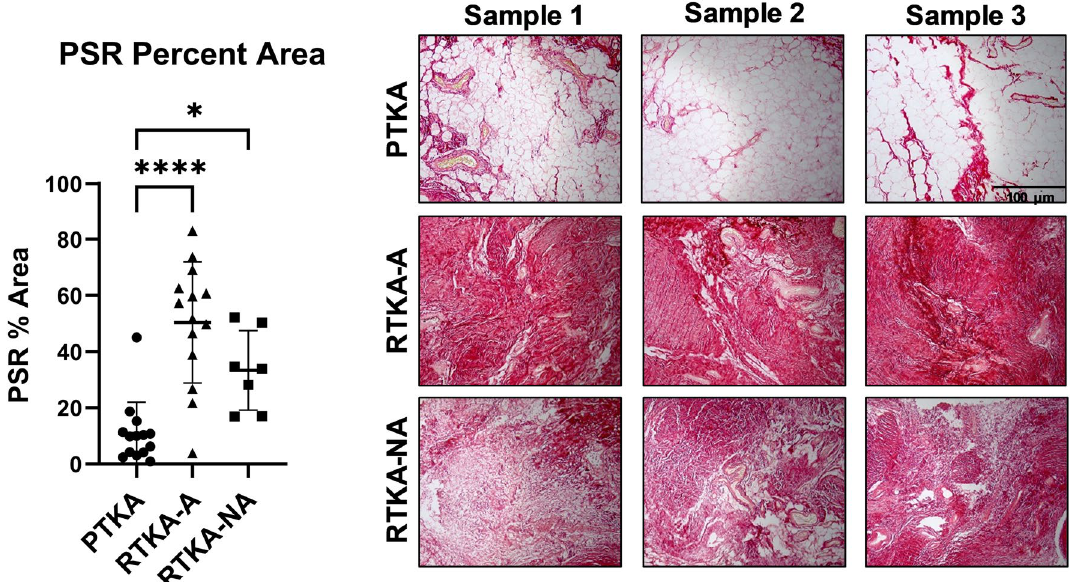
Figure 3. Picrosirius red staining of periarticular knee tissue. Picrosirius red staining quantification and representative images of three patients from the three patient groups ( PTKA = primary TKA, RTKA-A = arthrofibrosis, RTKA-NA = non-arthrofibrosis). The graphs depict mean picrosirius red staining (PSR) percent area ± standard deviation, with each data point representing one patient (average of three areas). Asterisk denotes a significant difference, (*p ≤ 0.05; ****p ≤ 0.0001), by the Wilcoxon Rank Sum test. The scale bar applies to all images in this